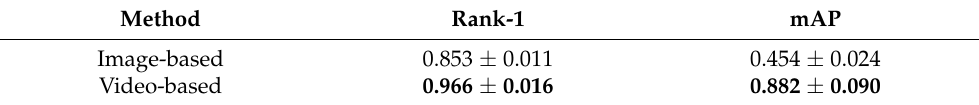
Table 3. Performance of the image-based and video-based re-ID approach. The rank-1 score, as well as the mean average precision (mAP), is given as a mean result of all runs of the five-fold cross-validation, including the overall standard